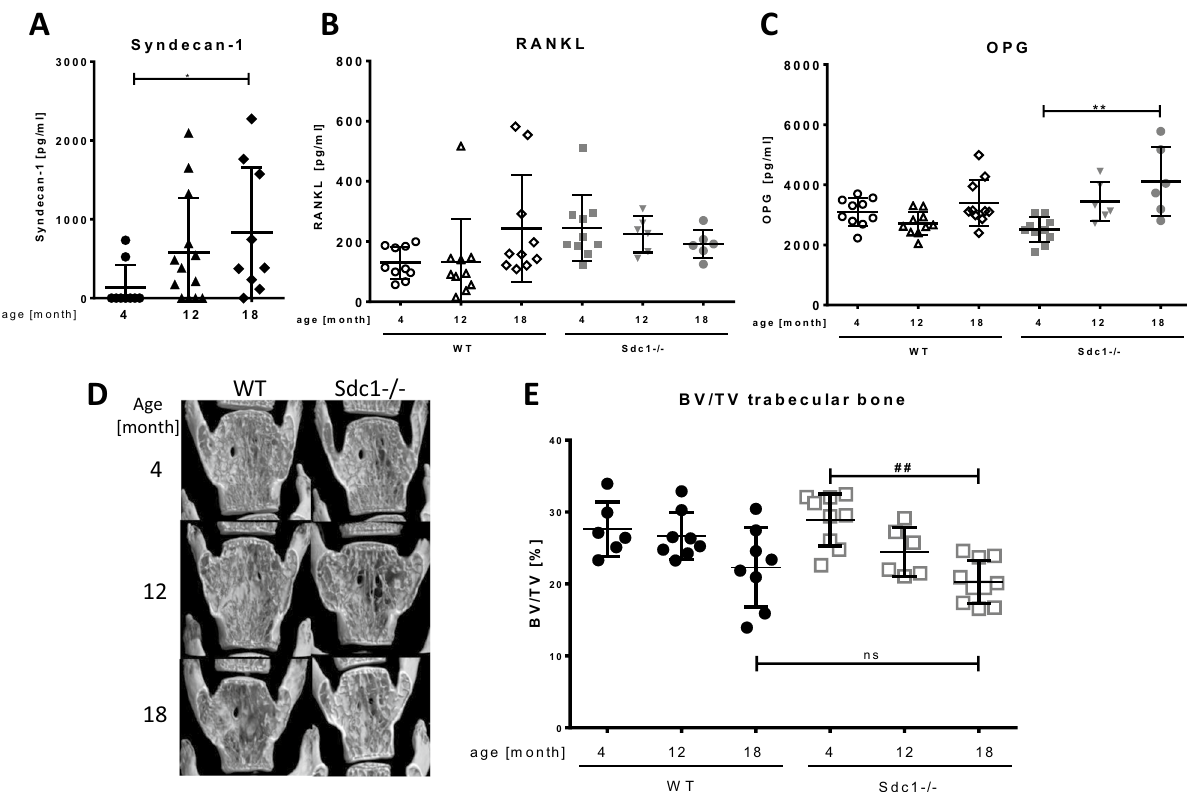
Figure 5. Influence of Syndecan-1 deficiency on serum concentration of RANKL and OPG and bone structure in mice during aging. ( A–C ) Serum was collected from female mice (WT (all), Syndecan-1 KO (only in B,C )) of 4, 12 and 18 month of age and concentration of Syndecan-1 ( A ), RANKL ( B ) and OPG ( C ) was determined by ELISA. Data are displayed as mean ± SD, Kruskal–Wallis test with Dunn´s post hoc test, n = 9–13 per group. * p < 0.05, ** p < 0.01. D, E : Lumbar vertebrae of mice (wild type, Syndecan-1-/-) at the age of 4, 12 and 18 month were isolated and fixed using 4% PFA. Bone structure was assessed by µCT. Representative pictures of fifth lumbar vertebrae of each age group are shown in ( D) , Quantitative analysis of bone volume/tissue volume (BV/ TV) of the trabecular bone in the vertebra body is shown in ( E ). See Supplemental Table 1 for additional bone parameters. Data are displayed as mean ± SD, Kruskal–Wallis test with Dunn’s post hoc test, n = 6–10 per group. # p < 0.05, ## p < 0.01, ns: no significant